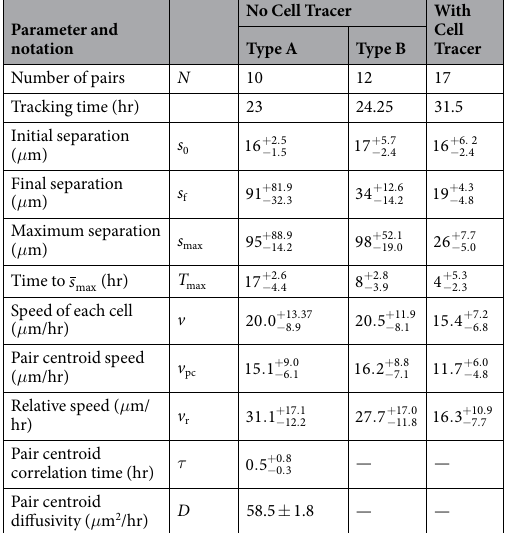
— Table 2. Parameters characterising the migration of hESC pairs, both in the absence and in the presence of Cell Tracer. We present the representative median values, and errors as their upper and lower quartiles. The diffusivity was obtained for Type A cells using the fit to L 2 shown in Figure S7a and the correlation time from τ = 2 D / v 2 for instantaneous